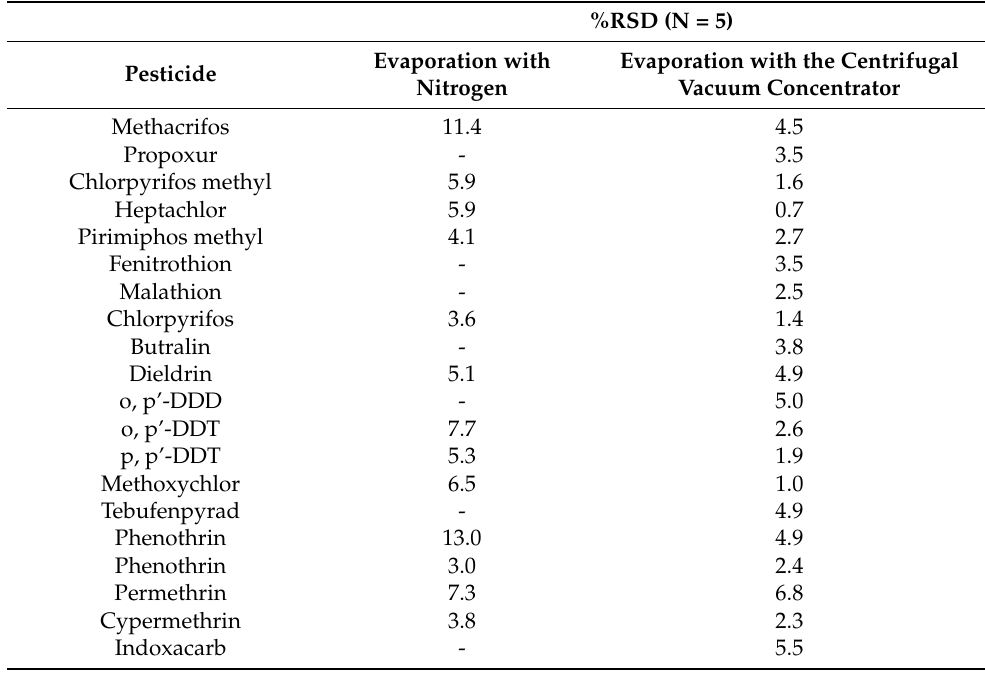
Table 4. Indicative results of %RSD (repeatability) of the methods for 5 replicates, using the two different evaporation methods. The “-” symbolizes pesticides which did not meet the validation requirements (mentioned in Section 2.10) or were not